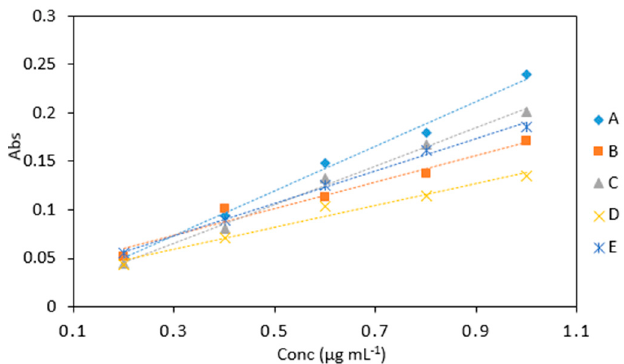
Figure 7. A comparison of arsenic samples (0.2–1 μ g mL − 1 ) analyzed using several reagent ratios: (A),